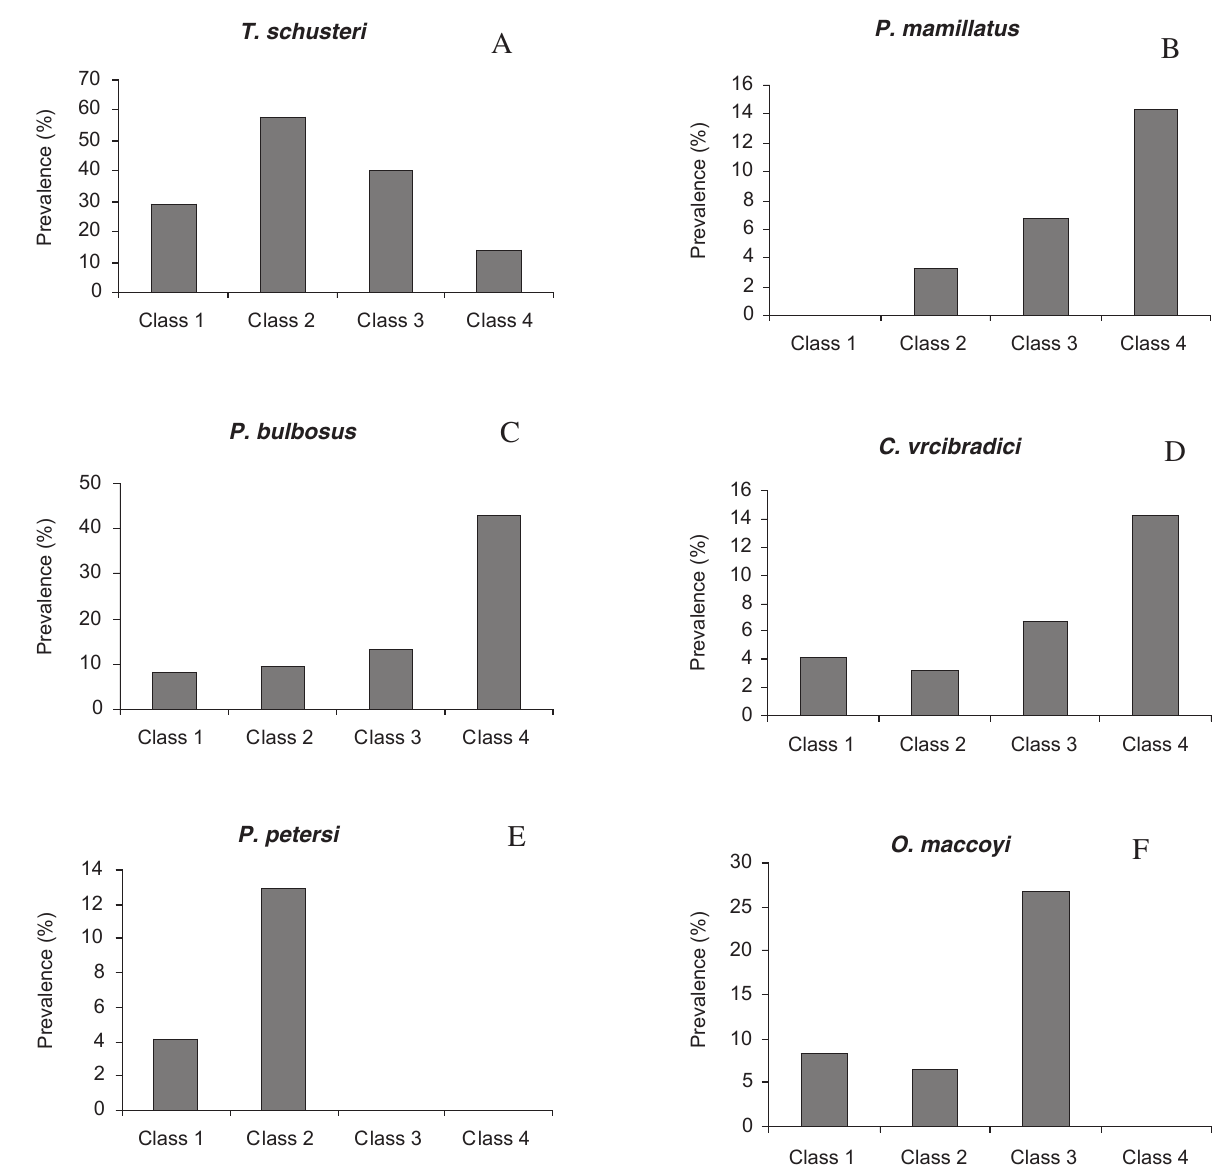
Fig. 2 . – A-F: prevalence of different helminths related to host weight